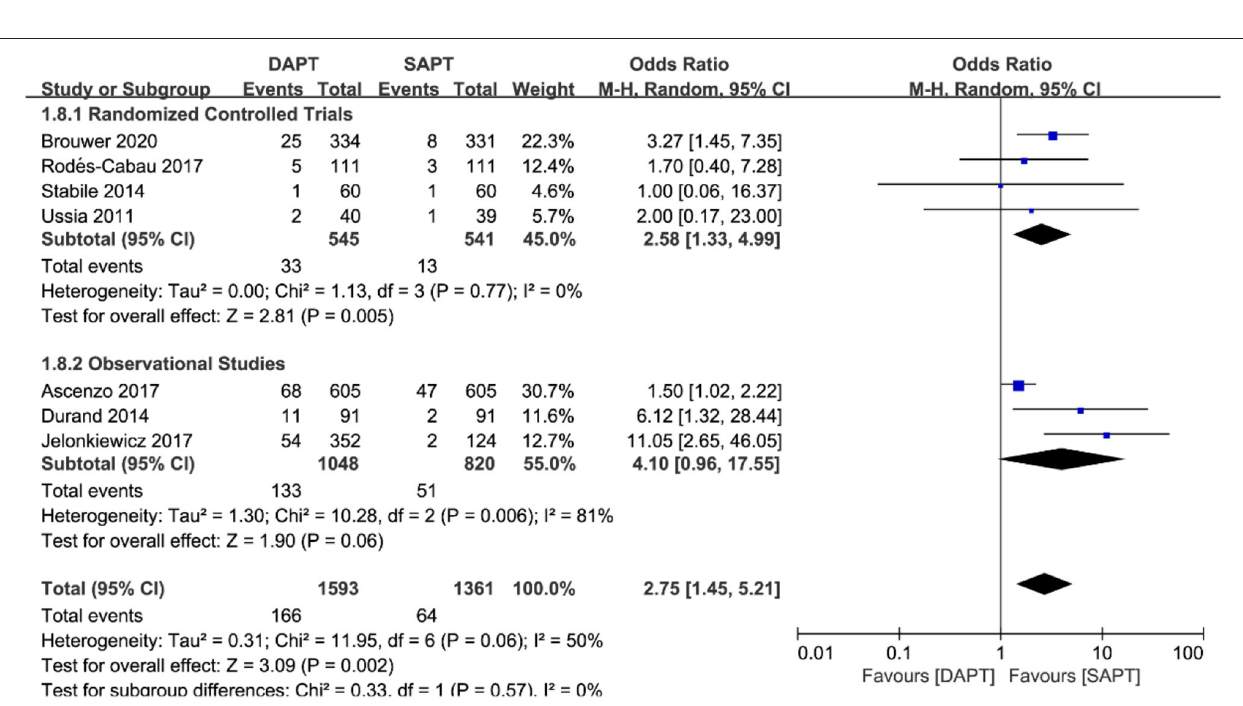
Frontiers in Cardiovascular Medicine |